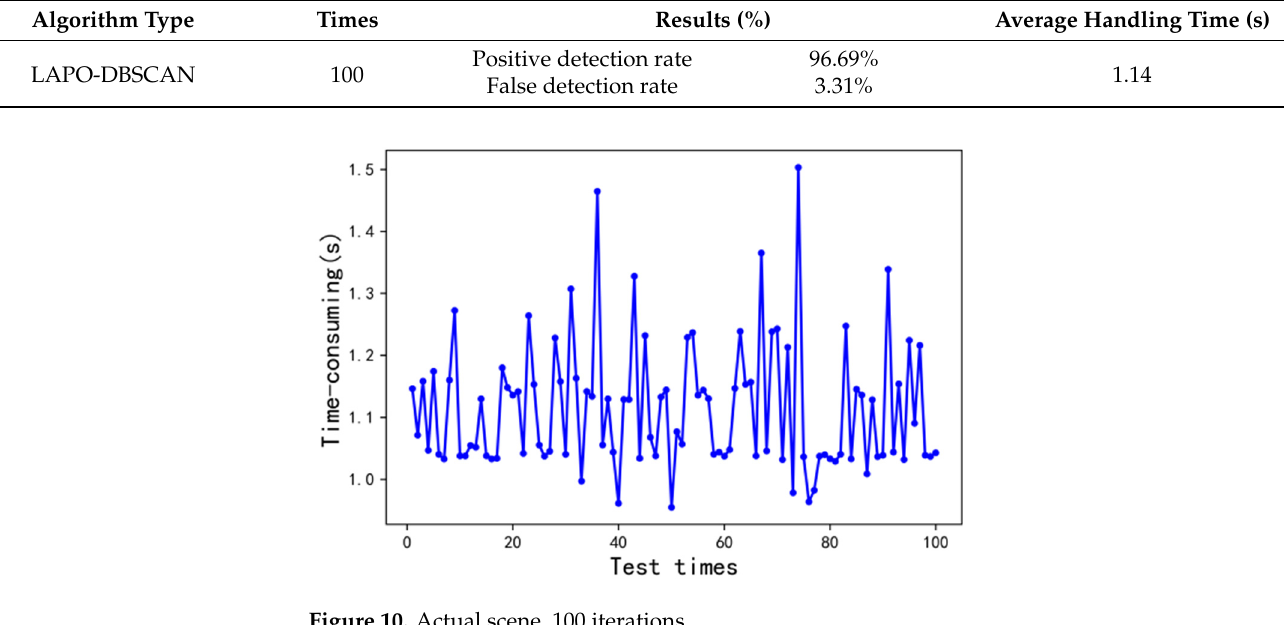
Figure 10. Actual scene, 100 iterations.